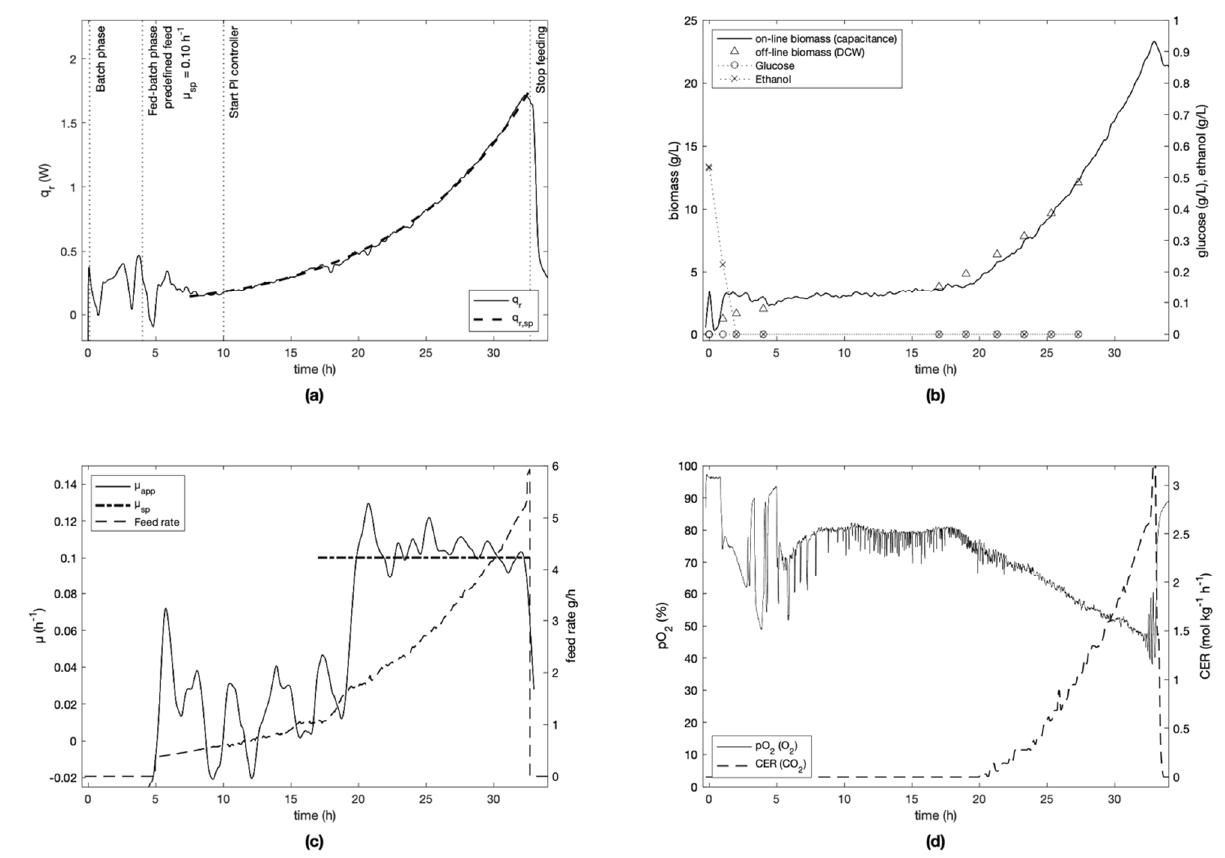
Figure 7. Fed-batch culture (E-5) of S. cerevisiae with µ sp of 0.10 h − 1 . ( a ) q r and q r,sp profiles. Events indicated by vertical lines. ( b ) Biomass profiles. Glucose and ethanol concentrations. ( c ) µ app from dielectric spectroscopy, µ sp and F feed . Controller MRE of 12% achieved. ( d ) pO 2 and CER.